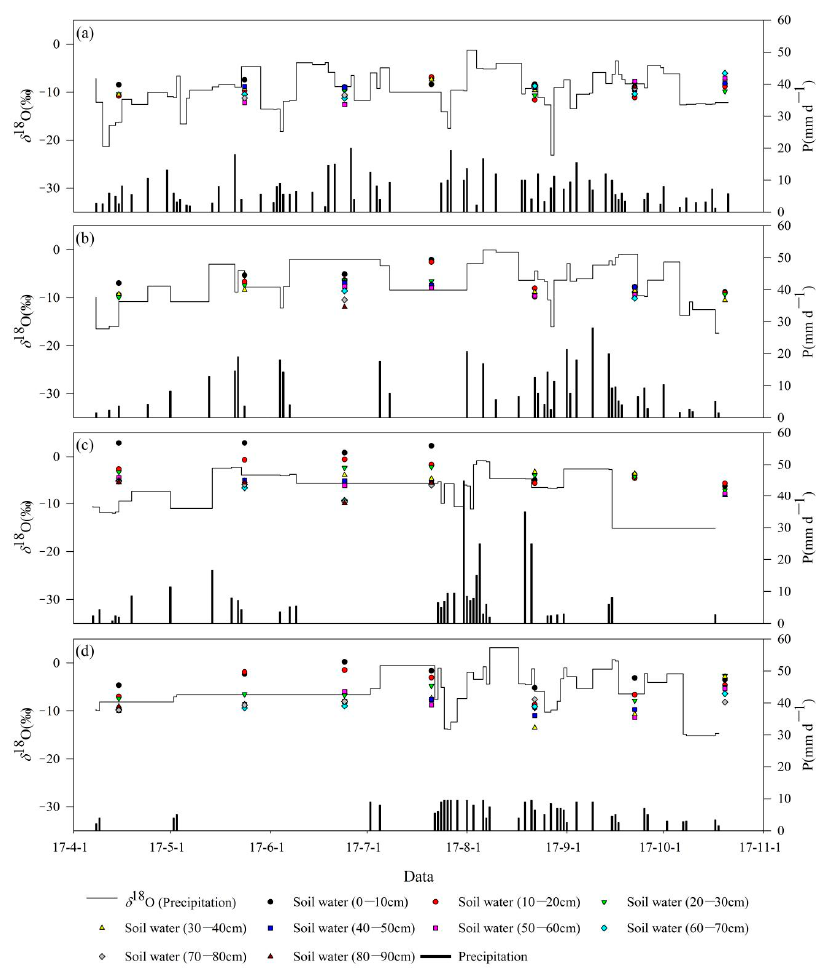
Figure 3. δ 18 O values for water samples of soil water at different depths and precipitation at the four stations (( a ) Lenglong; ( b ) Ningchan; ( c ) Huajian; ( d ) Xiying).